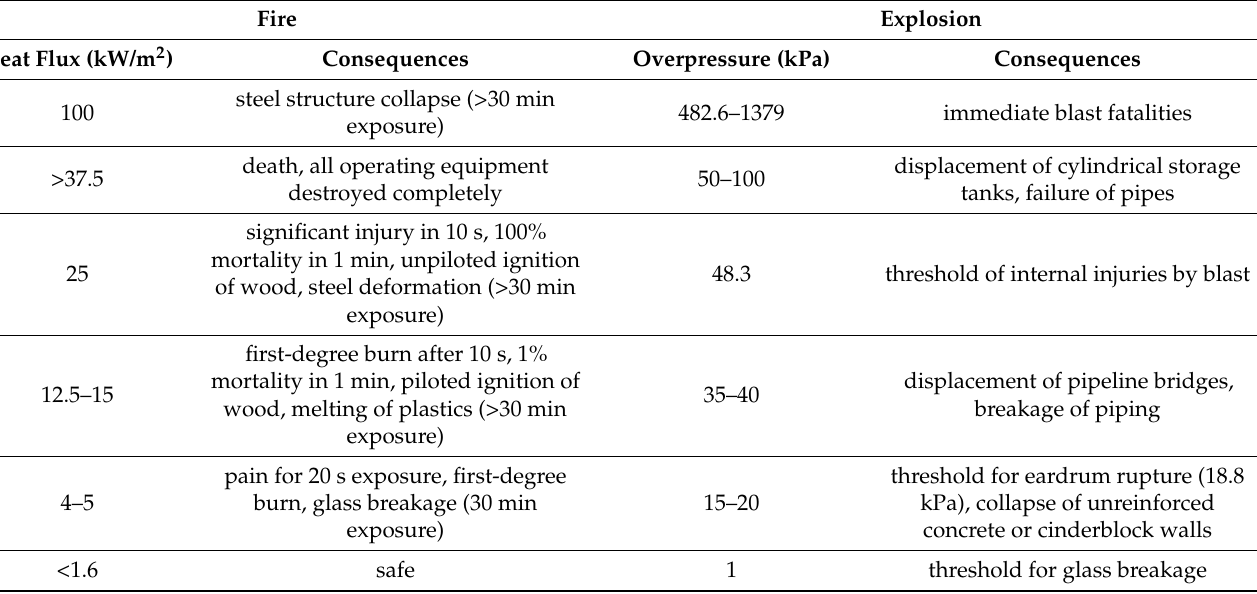
Table 4. Consequences of fire and explosion